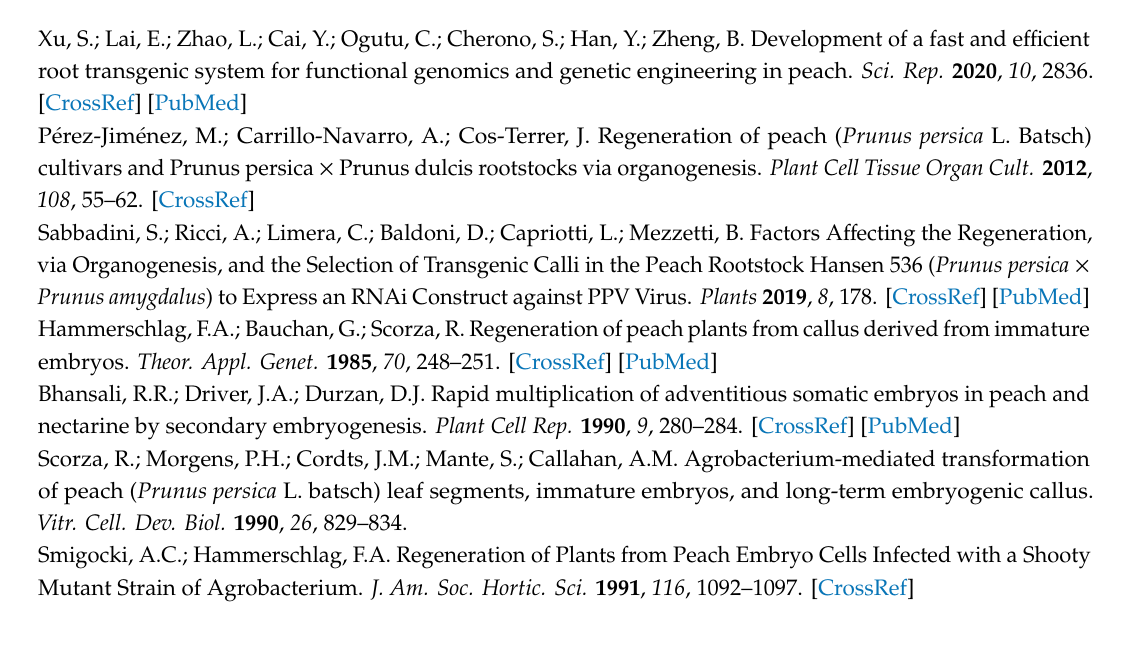
Figure S1: Caulogenesis and leaf regeneration from Hansen 536 explants. Figure S2: Hansen 536 leaf explants cultured with the abaxial or adaxial sides on regeneration